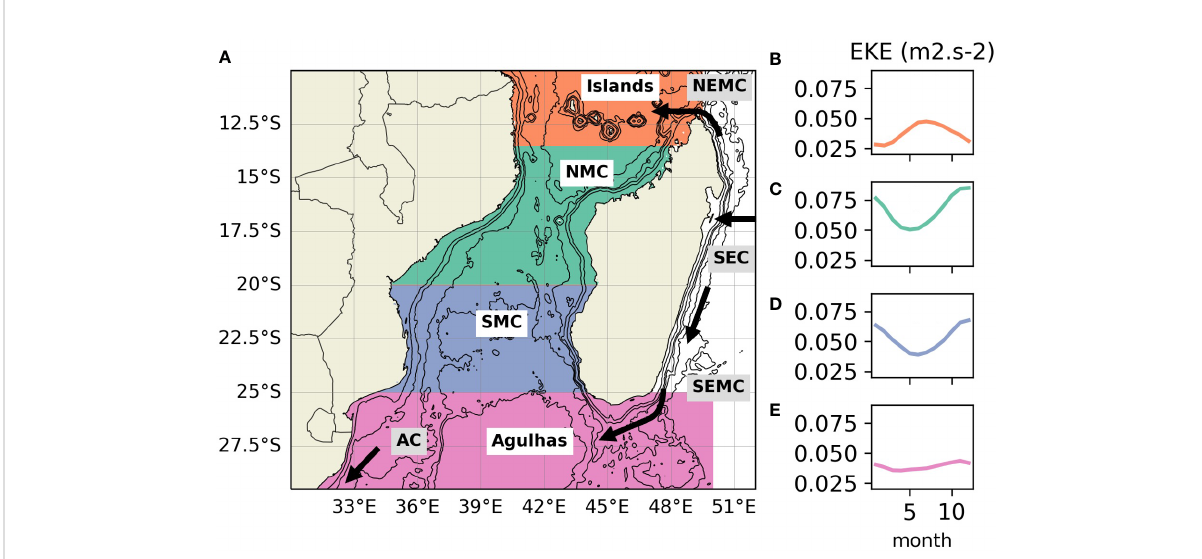
FIGURE 1 Major currents in the Mozambique Channel, its 4 subregions (A) , and their respective EKE climatology (B – E) . The subregions are de fi ned in the text as “ Islands ” (10°S- 13.5°S), “ North Mozambique Channel ” (NMC: 13.5°S- 20°S), “ South Mozambique Channel ” (SMC: 20°S-25°S) and “ Agulhas ” (25°S- 30°S). The major currents, South Equatorial Current (SEC), North East Madagascar Current (NEMC), South East Madagascar Current (SEMC) and the Agulhas Current (AC) are indicated by arrows. The background contours represent isobaths at -200, -1000, -2000, -3000 and -4000